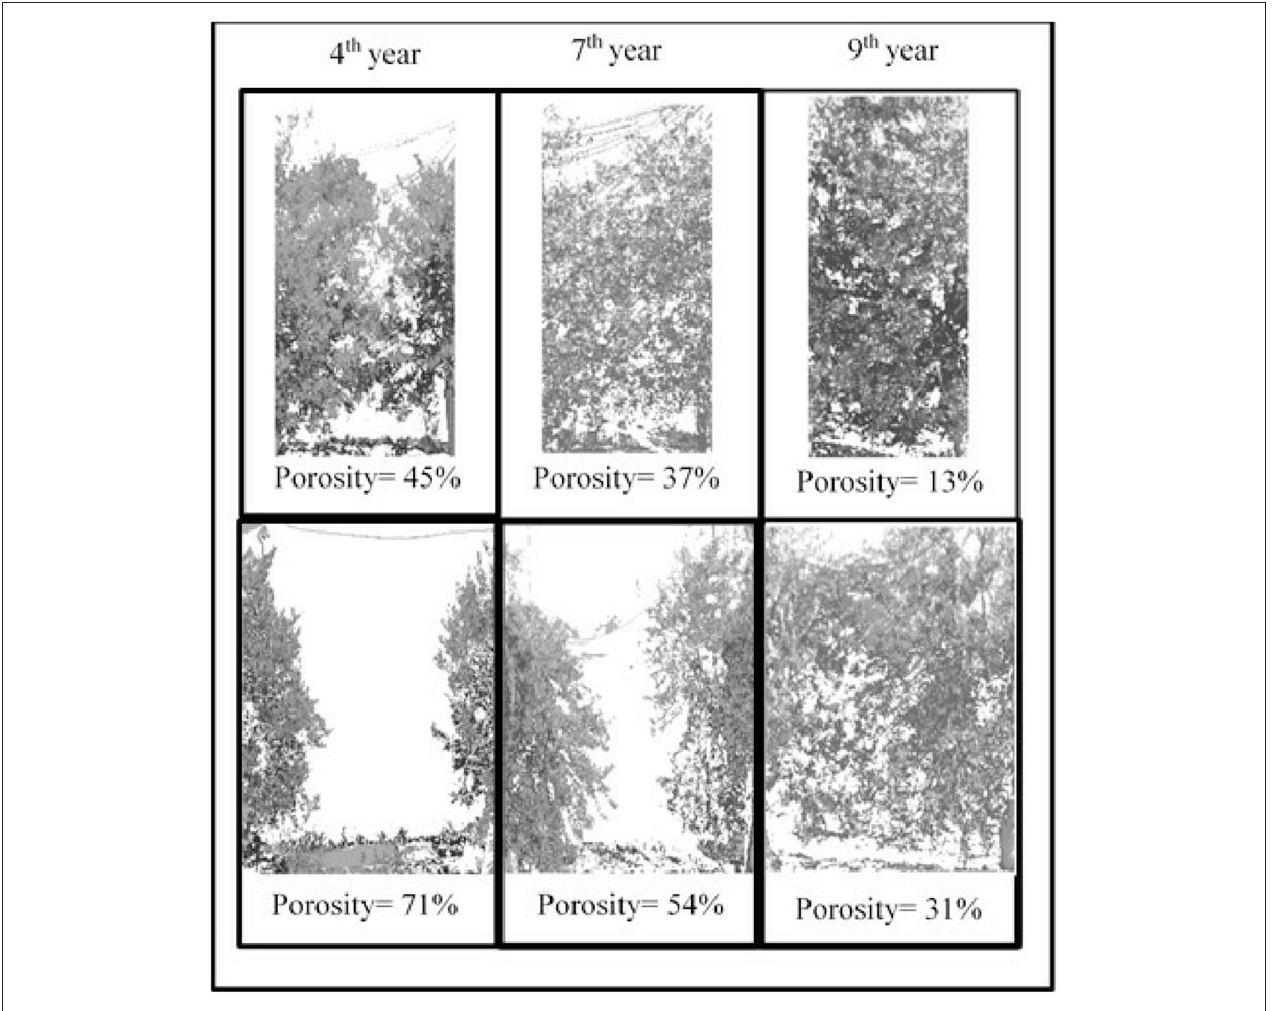
FIGURE 1 | Digital image analysis for estimation of hedgerow porosity. All hedgerows are spaced at 4m. Upper and lower panels are hedgerows with intra-row spacing of 1.13m (upper panels) and 2.38m (down panels) in the 4th, 7th, and 9th year after planting, respectively. The images were processed to discriminate between canopy cover and gaps between trees. Porosity (%) was determined from the ratio of the number of red pixels (background sheet) to the total number of pixels in the image.